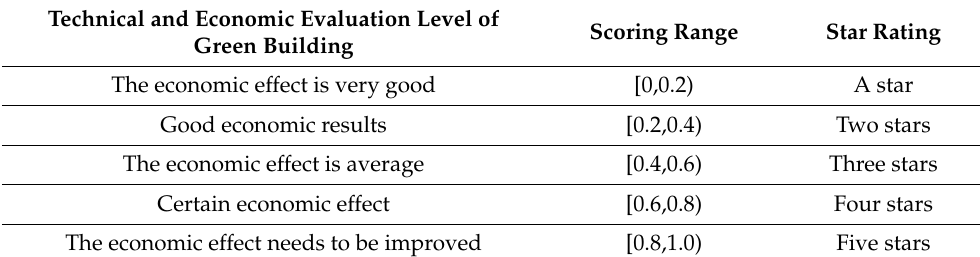
Table 2. Grade scale of technical and economic evaluation of green building.